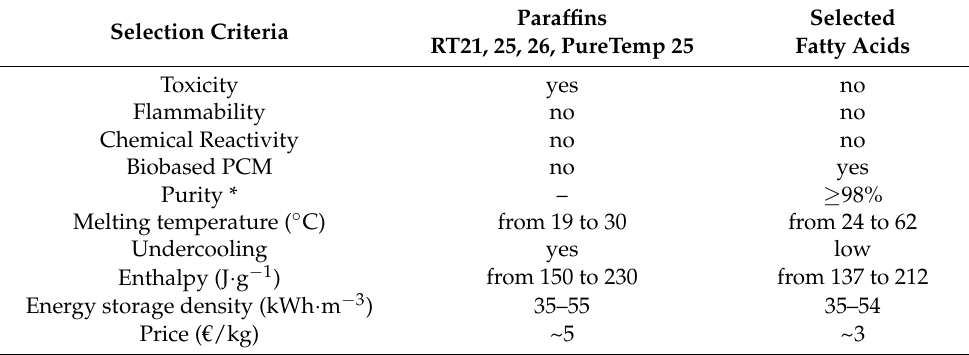
Table 1. Comparison of paraffins and fatty acids properties [29,34–36]. Selection Criteria